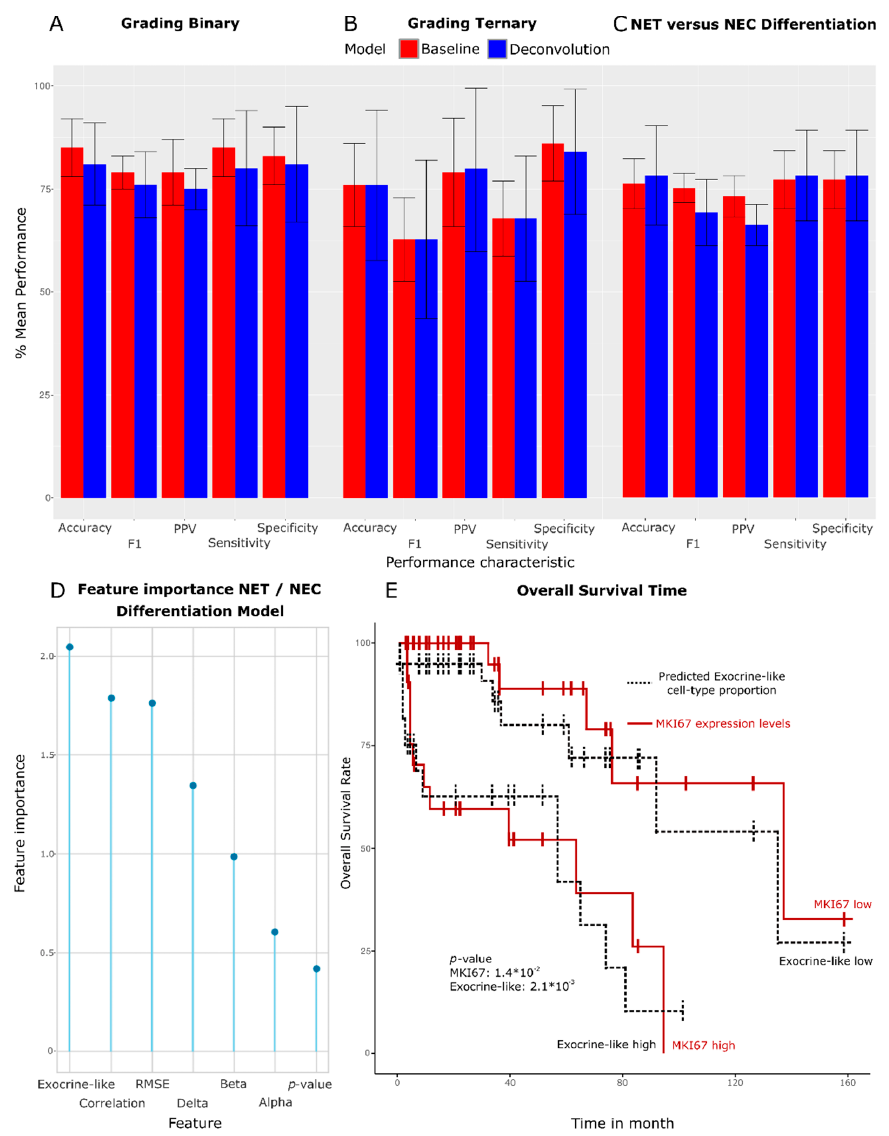
Figure 5. Statistical power of a deconvolution-trained ML model to predict clinically relevant characteristics. Plot ( A ): predictive power of a deconvolution model relative to a baseline model trained on expression data and MKI67 levels. The baseline model shows slightly higher mean performances, but the performance of either model remains comparable with respect to the discernibility of G3 panNENs from medium- and low-grade G2 and G1 panNENs. Plot ( B ): ternary grading classification performances. The baseline model predicts the specific G1 or G2 or G3 class of a panNEN with a comparable performance as the deconvolution model. Plot ( C ): the performance of the deconvolution model with respect to the classification of a panNEN as either NET or NEC remains comparable to the baseline model with the exception of the F1-score and the positive predictive value (PPV), which is greater in the baseline model. Plot ( D ): feature importance of a deconvolution model tasked with discerning pancreatic NECs from NETs. The exocrine-like cell type proportion was most informative when telling NECs apart from NETs, followed by the quality with which a panNEN could be reconstructed during deconvolution. Endocrine cell type-related properties proved to be of limited relevance. Plot ( E ): Kaplan–Meier plot of the overall survival time of all samples with survival time annotation in the Riemer and Scarpa dataset. MKI67 baseline as well as the exocrine-like cell type proportion stratified NEN patients into a ‘high’- or ‘low’- risk group membership with comparable Cox hazard ratio test’s p -value for this binary